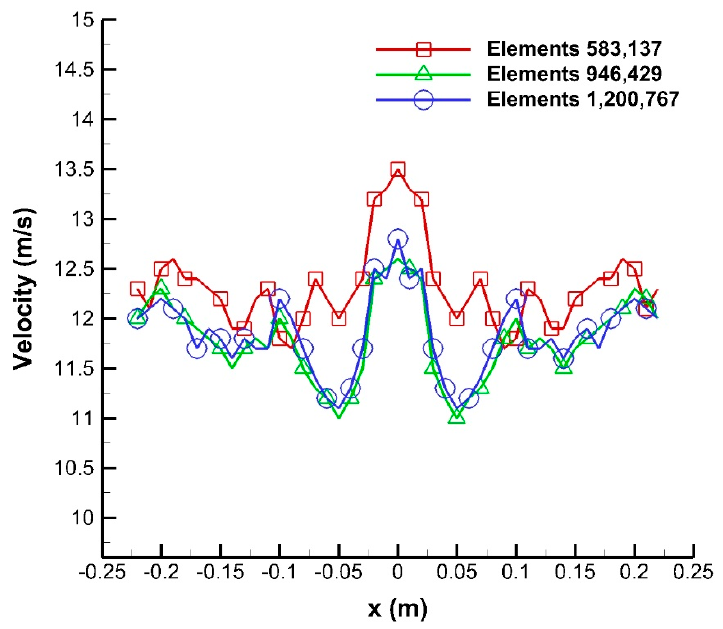
Figure 5. Grid independence check for velocity at the outlets along the lengthwise (x) direction.